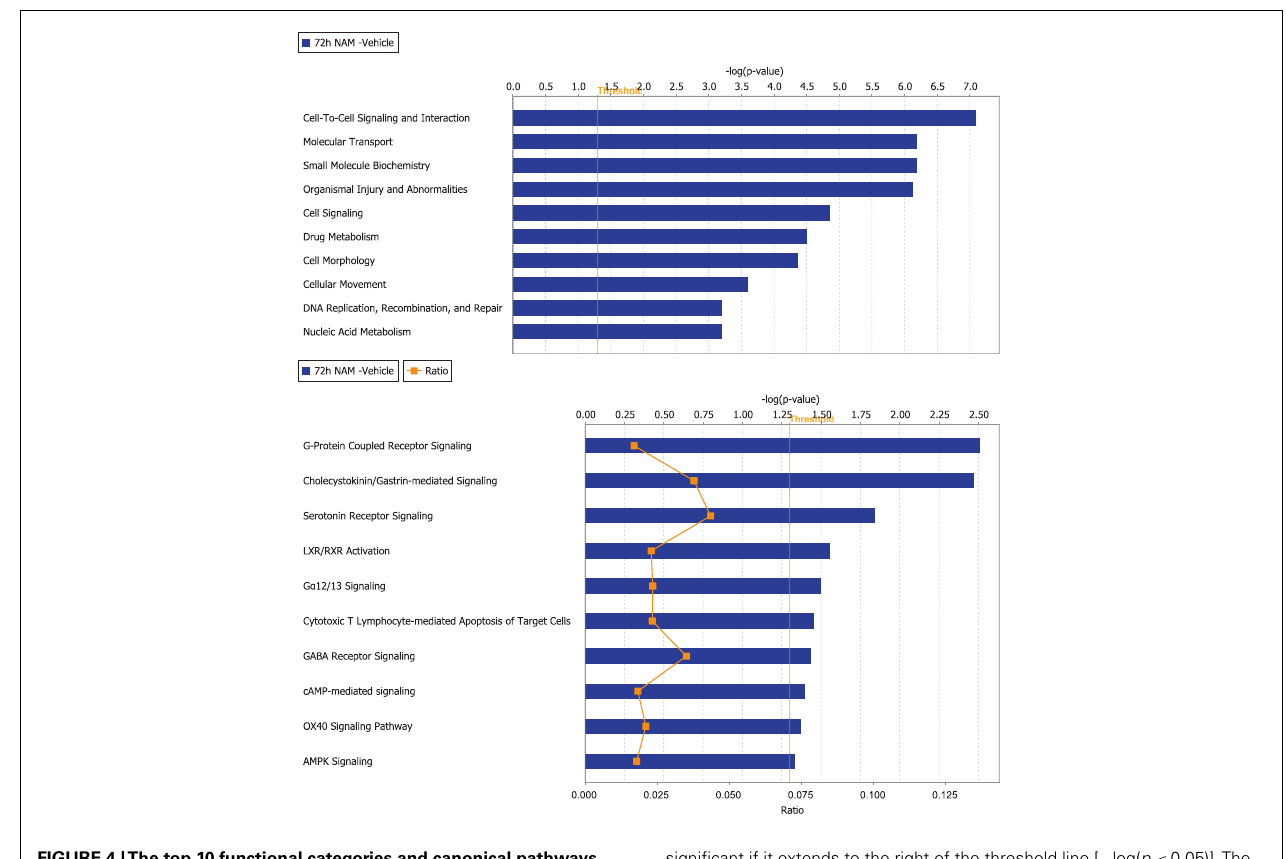
FIGURE 4 |The top 10 functional categories and canonical pathways involving significantly regulated genes in the nicotinamide treated compared to vehicle treated CCI injured animals for the 72-h time point. The length of the bar is the negative log of the p- value and is